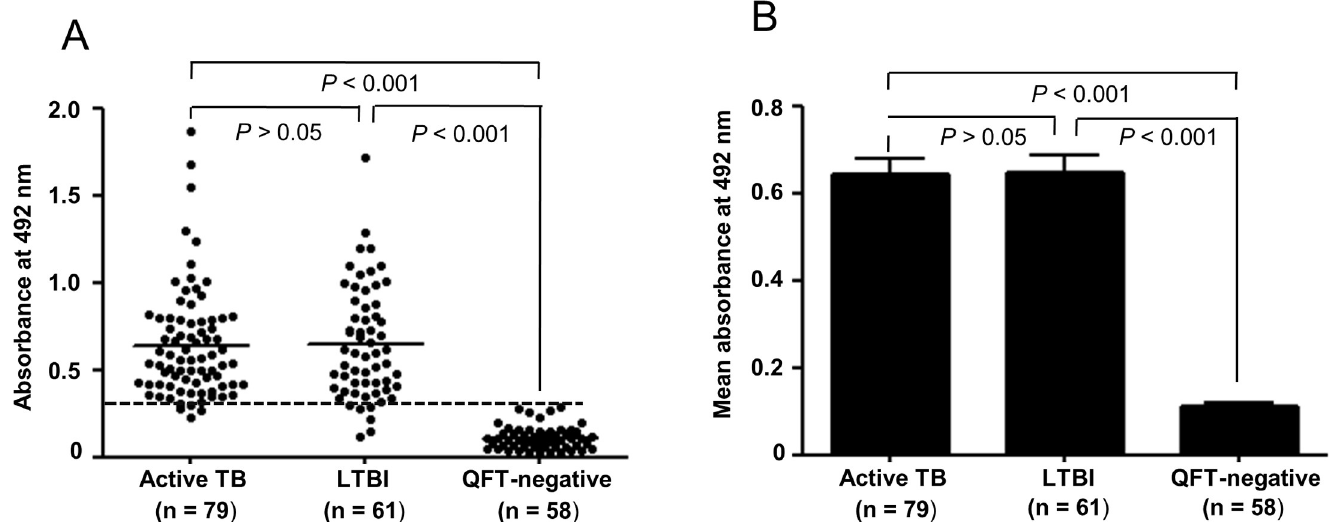
Fig 1. PPE17 (Rv1168c) displays higher antibody responses in individuals with active TB and latent TB. (A). Mean absorbance values (indicated by horizontal line) of PPE17 for active TB and LTBI individuals as well as QFT-negative subjects were compared following ELISA. (B). Data shown for individual samples in Fig 1A were re-plotted to show the mean ± SEM values. The mean ± SEM values for active TB, LTBI and QFT-negative subjects were 0.646 ± 0.035, 0.648 ± 0.041 and 0.113 ± 0.008 respectively.